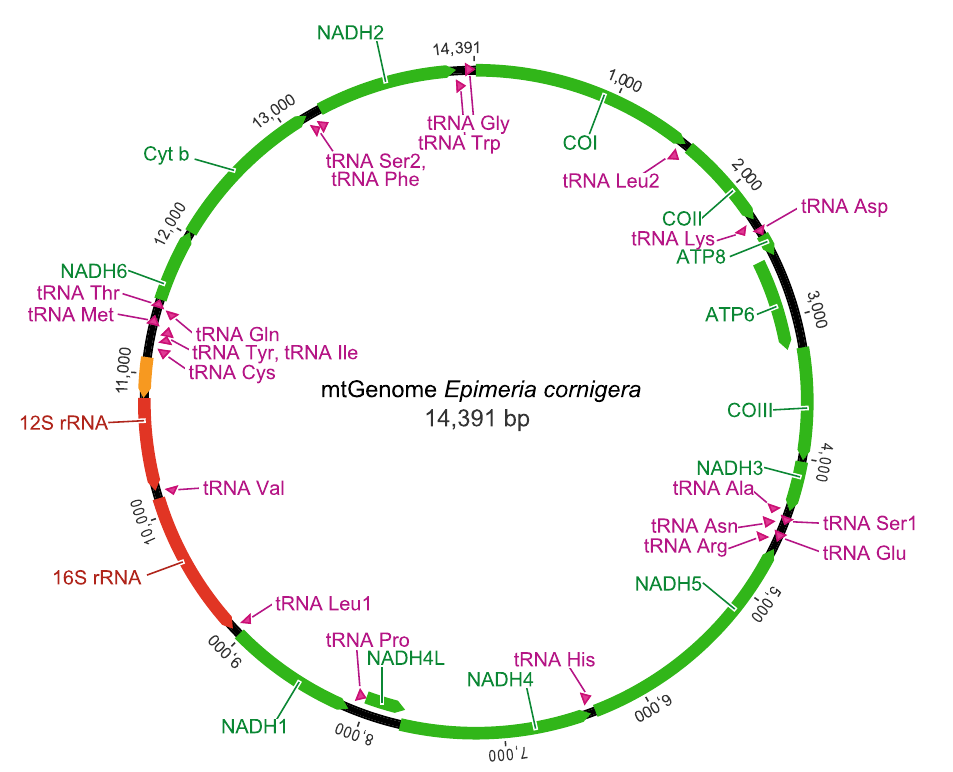
Figure 4. Organization of the mitochondrial genome of Epimeria cornigera . Protein encoding genes are marked in green, ribosomal RNAs in red, tRNAs in violet, and the putative control region in orange. Abbreviations: ATP6/8: ATPase subunits 6/8; COI-III: Cytochrome c oxidase subunits I–III; NADH2-6/4 L: NADH dehydrogenase subunits 1–6/4 L, and Cyt b: Cytochrome b. All 22 transfer RNA genes are designated by tRNA-X and labeled according to the IUPAC-IUB single-letter amino acid codes. Arrowheads indicate the direction of